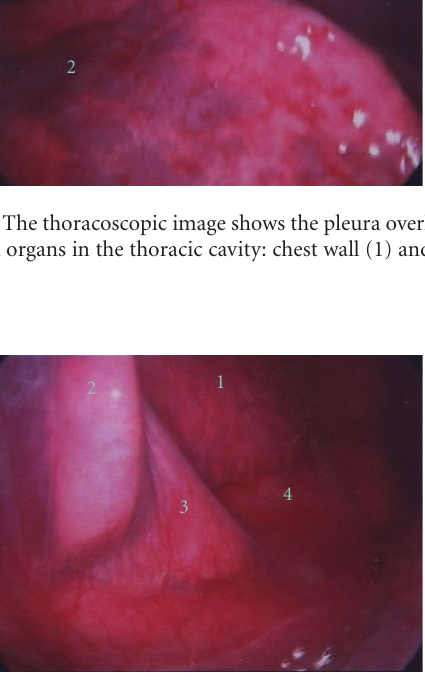
Figure 2: The thoracoscopic image shows the pleura overlaying the tissue and organs in the mediastinum: heart (1), descending aorta (2), inferior pulmonary ligament (3), and diaphragm (4).